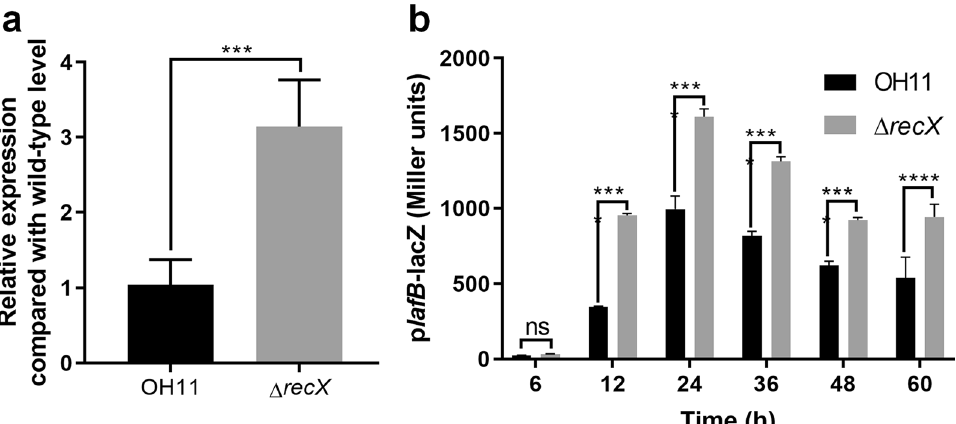
Fig. 6 Lysobacter enzymogenes RecX negatively regulated lafB expression. a RT-qPCR analyses of lafB mRNA in the wild-type and recX mutants grown in 10% TSB. b The effect of RecX on lafB gene expression was measured by assessing the β -galactosidase activity of the lafB -lacZ transcriptional fusion in the L. enzymogenes wild-type and Δ recX strains. Error bars, means assessed by one-way ANOVA. All experiments were repeated three times with similar